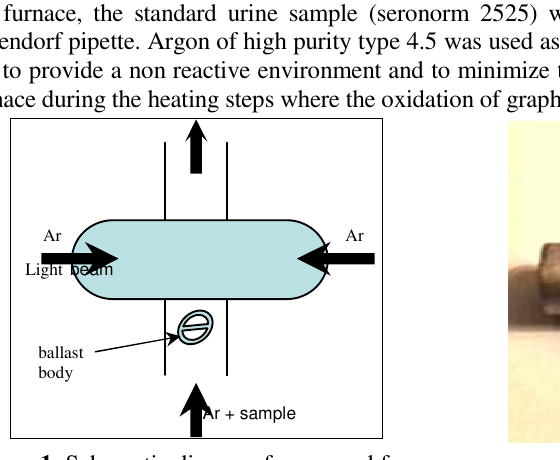
Figure 1. Schematic diagram for crossed furnace Figure 2. Real